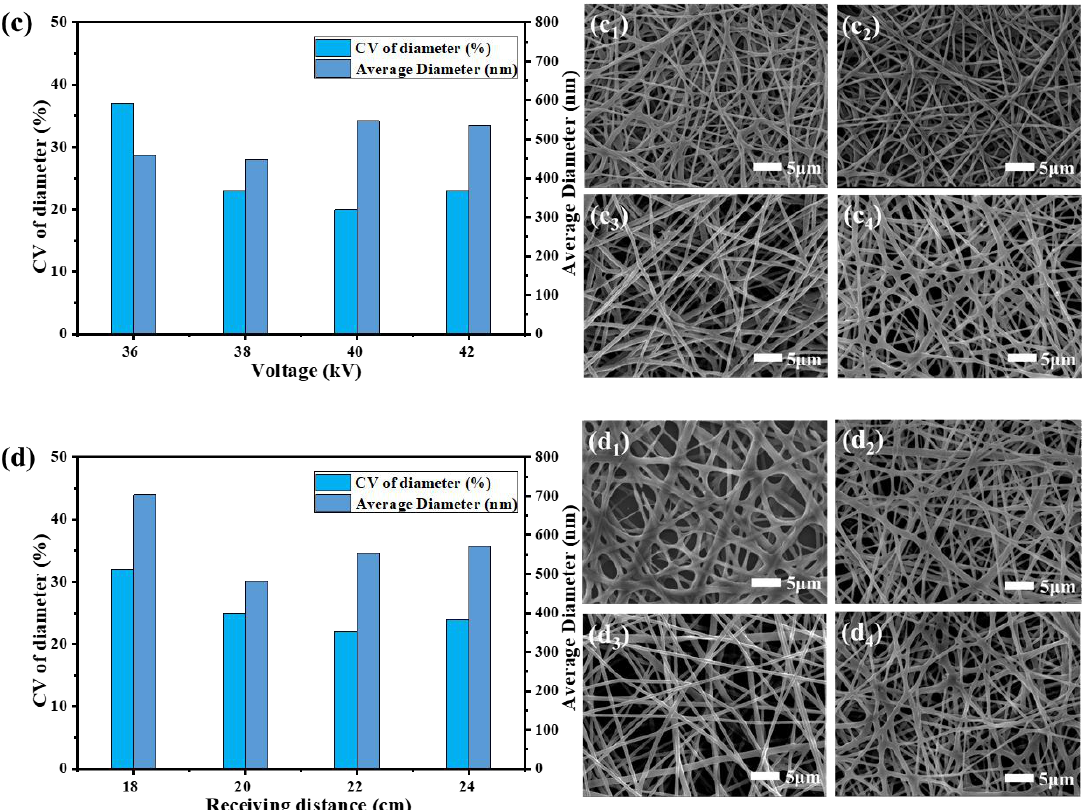
Figure 1. Average diameter, CV value of the diameter, and SEM images of γ -PGA/keratin ENSs under different spinning parameters. ( a ) Concentrations ( a 1 ~ a 4 represent SEM images of ENSs at a spinning solution concentration of 24%, 26%, 28%, and 30%, respectively). ( b ) γ -PGA/keratin ratios ( b 1 ~ b 4 represent SEM images of ENSs at a γ -PGA/keratin ratio of 9:1, 8:2, 7:3, and 6:4, respectively). ( c ) Voltages ( c 1 ~ c 4 represent SEM images of ENSs at a voltage of 36 kV, 38 kV, 40 kV, and 42 kV, respectively). ( d ) Receiving distance ( d 1 ~ d 4 represent SEM images of ENSs at a receiving distance of 18 cm, 20 cm, 22 cm, and 24 cm, respectively).